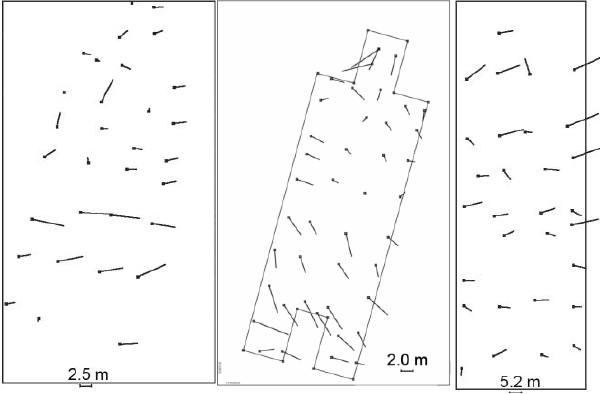
Figure 15: Discrepancies at check points, left: data set 1, centre: data set 5, right: data set